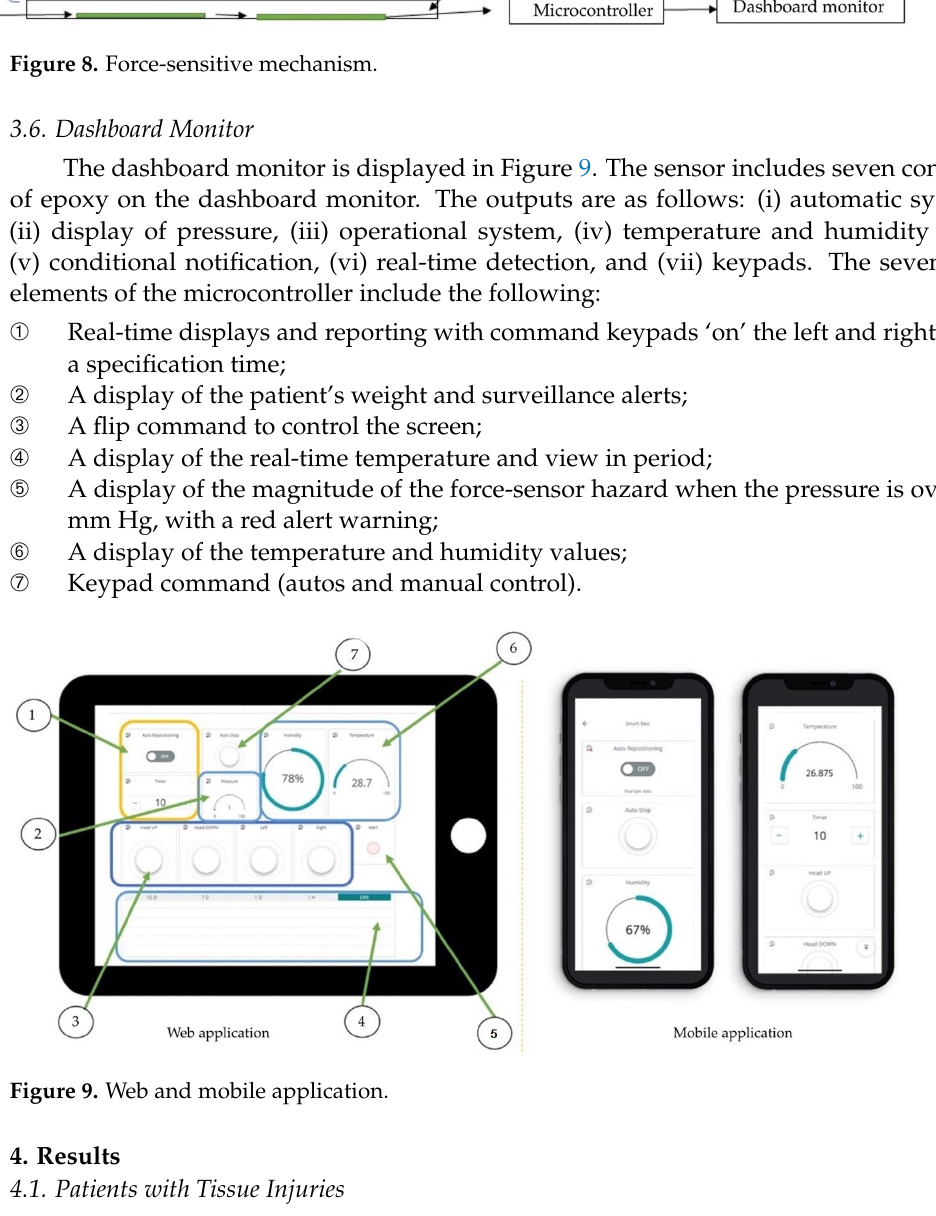
Figure 9. Web and mobile application.